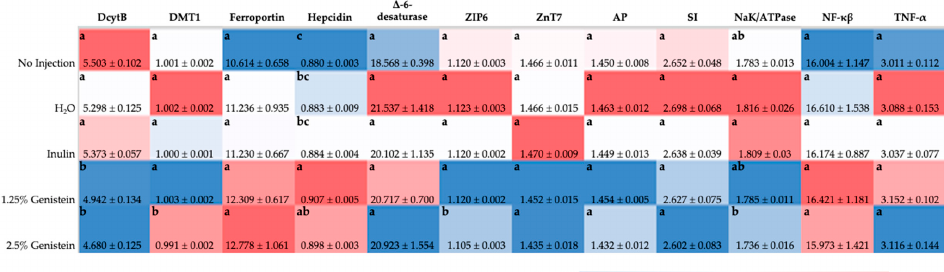
Figure 1. Effect of intraamniotic administration of genistein and controls on duodenal and liver (hepcidin) mRNA gene expression. Gene expression has been normalized to the 18S housekeeping gene and is in arbitrary units (AU). Values are presented as mean ± SEM, n = 6. a–c Per gene (in the same column), treatments groups not indicated by the same letter are significantly different ( p < 0.05) according to one-way ANOVA with post-hoc Duncan test. DcytB, duodenal cytochrome b; DMT1, divalent metal transporter 1; ZIP6, zinc transport protein 6; ZnT7, zinc transporter 7; AP, amino peptidase; SI, sucrose isomaltase; NaK/ATPase, sodium, potassium and adenosine